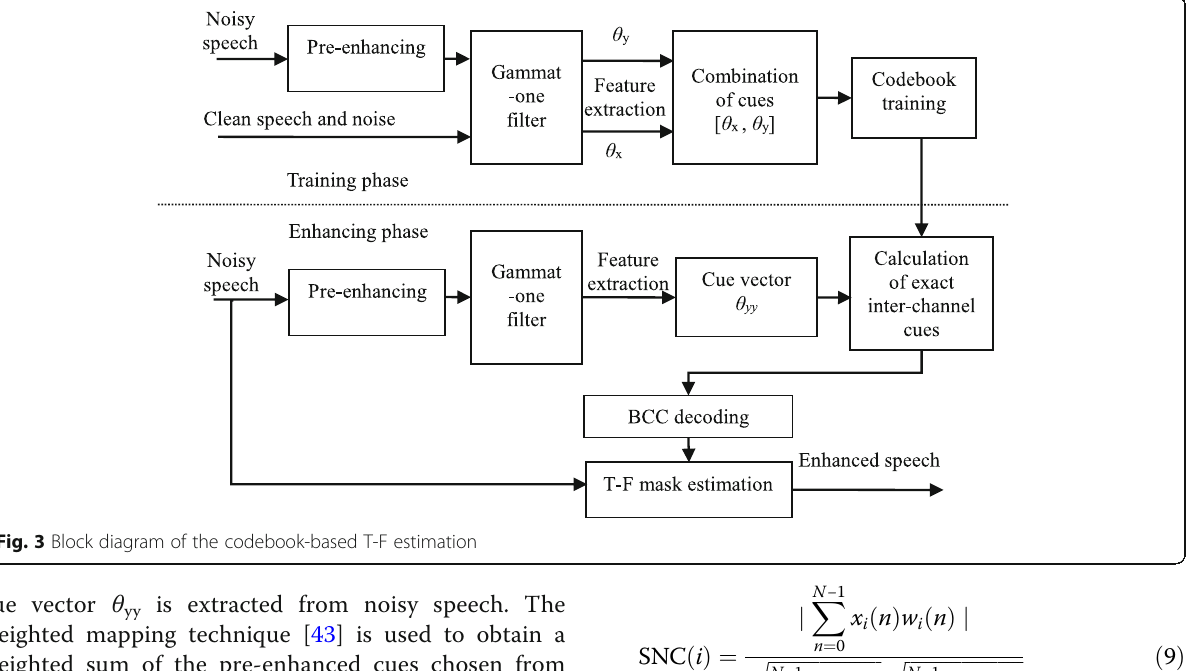
Fig. 3 Block diagram of the codebook-based T-F